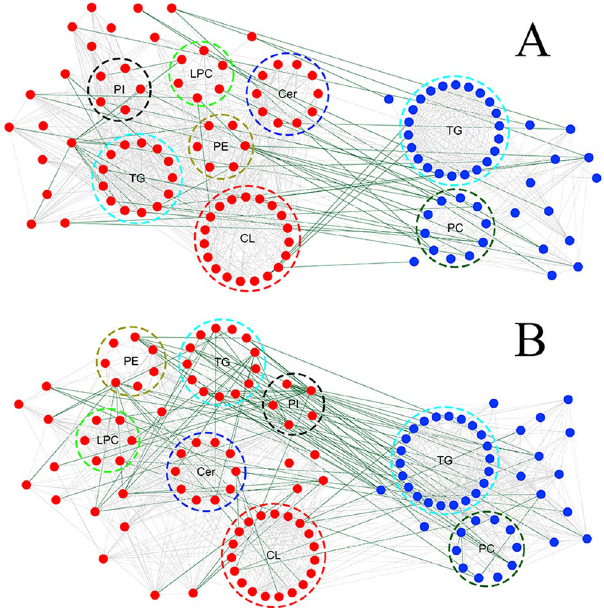
Figure 4. A correlation network of commonly altered lipid classes both within and across LVTA myocardial and serum specimens. Highly correlated lipid species were connected with lines (lipid species were included if they had correlation coefficients > 0.6). The dark green and light grey lines represent positive and negative correlations, respectively. The red and blue dots represent lipids in myocardia and sera, respectively. ( A ) ACO-LVTA model; ( B ) CAL-LVTA model; CL: cardiolipin, Cer: ceramide, PE: phosphatidylethanolamine,